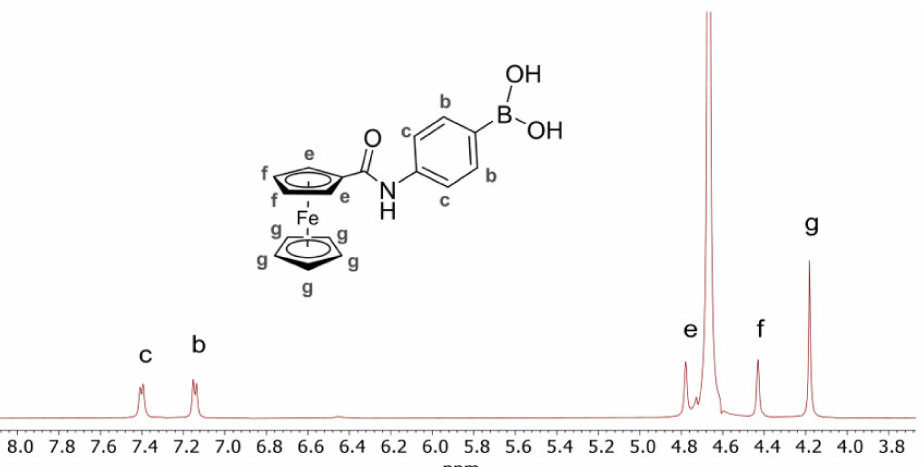
Figure 1. 1 H NMR (500 MHz, 5 mM, DMSO-d 6 /D 2 O 1:10 v/v, and [Na 2 CO 3 ] = 10 mM) spectrum of